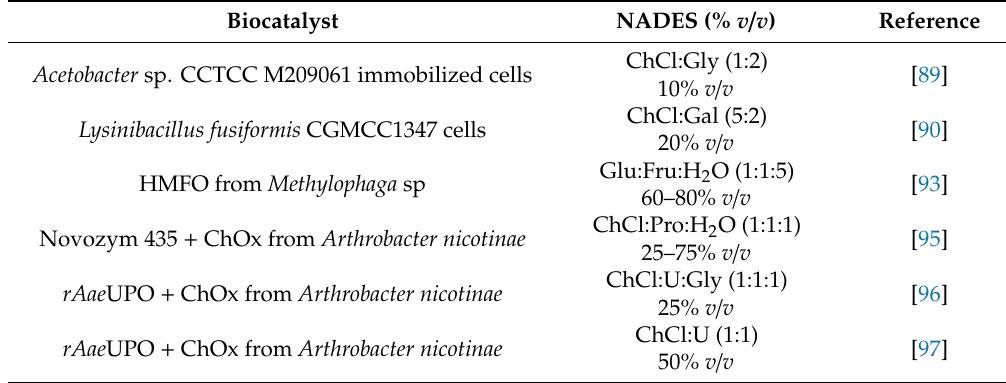
Table 4. Oxidations catalysed by biocatalysts in di ff erent